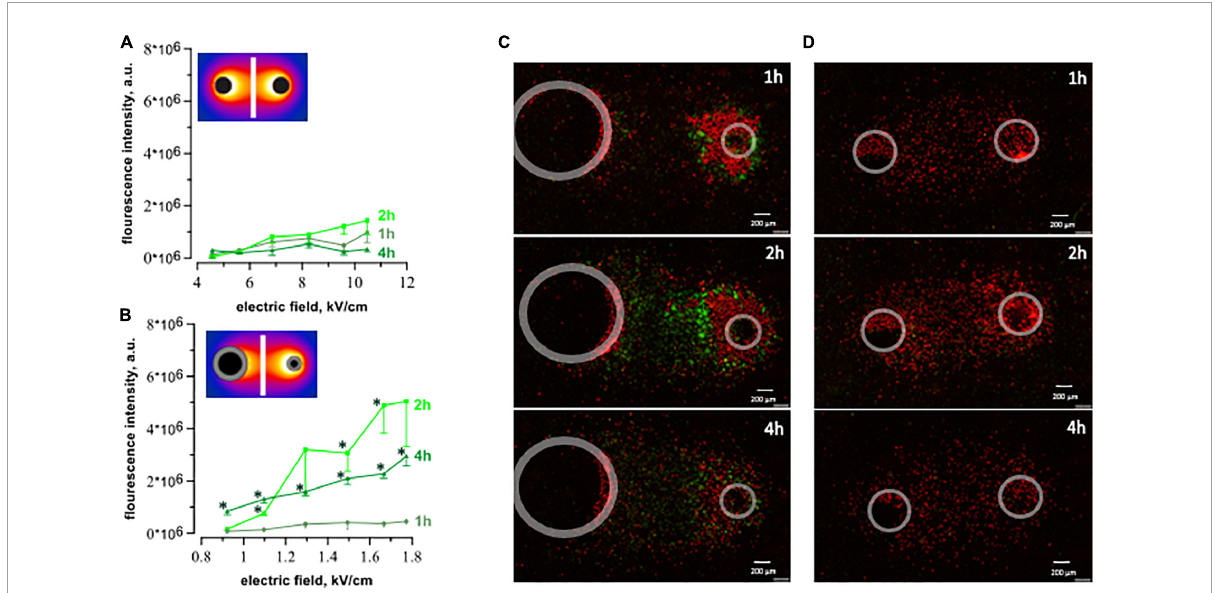
FIGURE7 Caspase 3/7 activation after exposure to 20 pulses with 100 µ s duration (1 Hz, 300 V) and 200 pulses with 300 ns duration (10 Hz, 1.74 kV). The plots display integrated fluorescence intensity of caspase 3/7 activity calculated for each region of interest (see text for details). Fluorescence was measured at 1-, 2-, and 4 h after exposure to ns- (A) and µ sPEF shocks (B) . Every single plot represents 3–5 independent experiments, * p < 0.05 for the difference between 1 h and 2- or 4 h. We observed an increase in caspase activity (green dye) following µ sPEF shocks (C) , but not after nsPEF shocks (D)